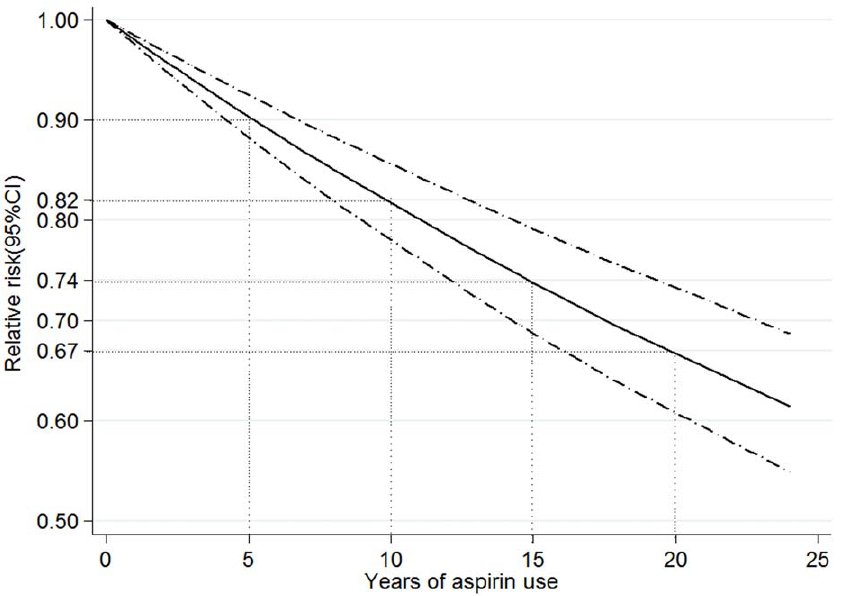
Figure 5. Association between years of aspirin use and risk of colorectal cancer obtained by linear dose-response meta-analyses. P linearity =0.000. Solid line represents the estimated relative risk and the dot-dashed lines represent the 95% confidence intervals. The dotted lines are used to explain the relative risk of colorectal cancer for different duration of aspirin use (RR=0.90, 95% CI 0.88–0.92, for 5 years of aspirin use; RR=0.82, 95% CI 0.78–0.86, for 10 years; RR=0.74, 95% CI 0.69–0.79, for 15 years; RR=0.67, 95% CI 0.61–0.73, for 20 years).